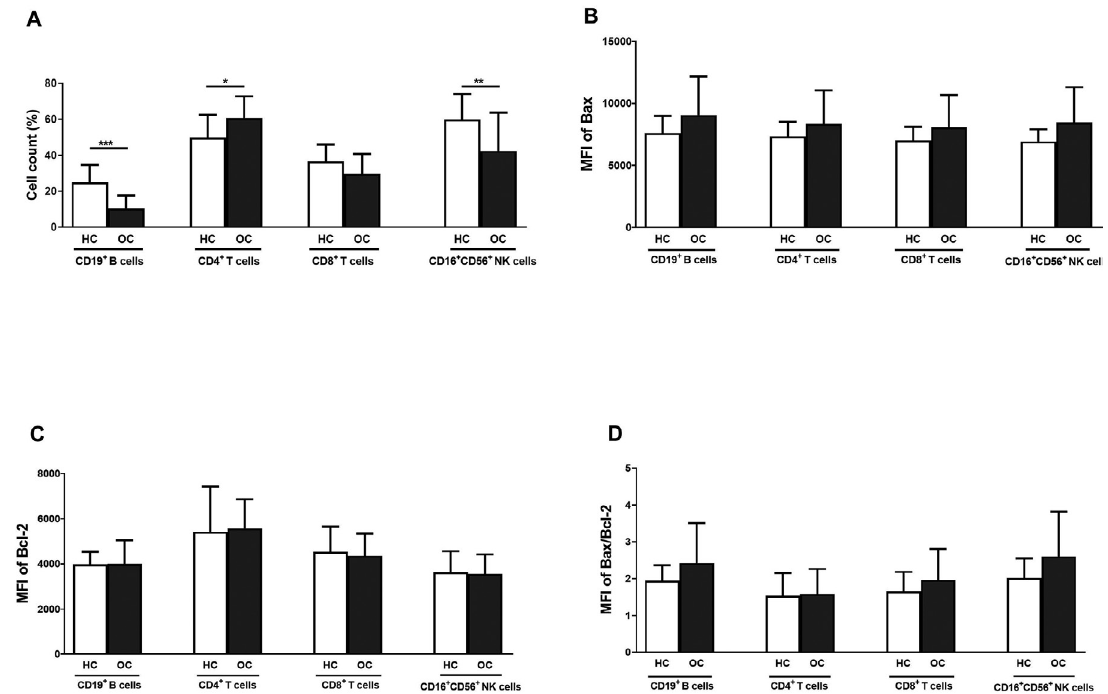
Figure 3- Comparison between OC and HC samples. Frequency lymphocyte subsets (A) and MFI of Bax (B), Bcl-2**: P<0.01 (C), and Bax/Bcl-2 ratio (D) of the four lymphocyte cell types. *: p <0.05, **: p <0.01, ***: p <0.001